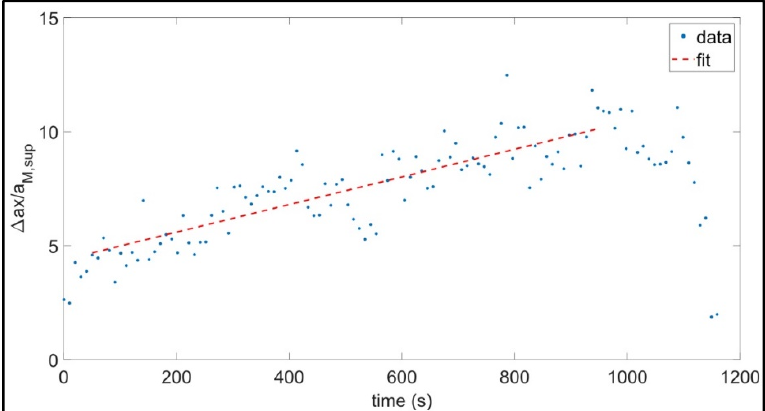
Figure 5. Example of correlation between the normalized ∆ ax parameter and time for an individual subject during walking. The regression equation is Δ ax/aM,sup = 4.379 + 0.006 t, for t in the range (50, 950) s, and the determination coefficient is R 2 = 0.70.